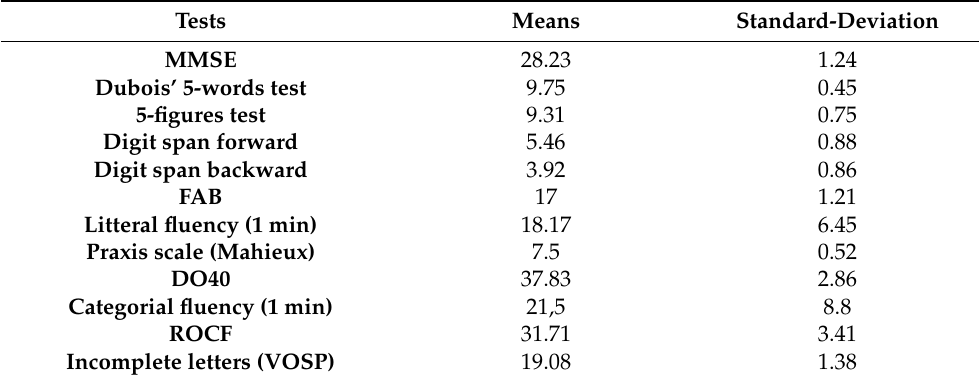
Table 4. Mean score and standard deviation of each test of the neuropsychological assessment performed between three and six months after recovery of